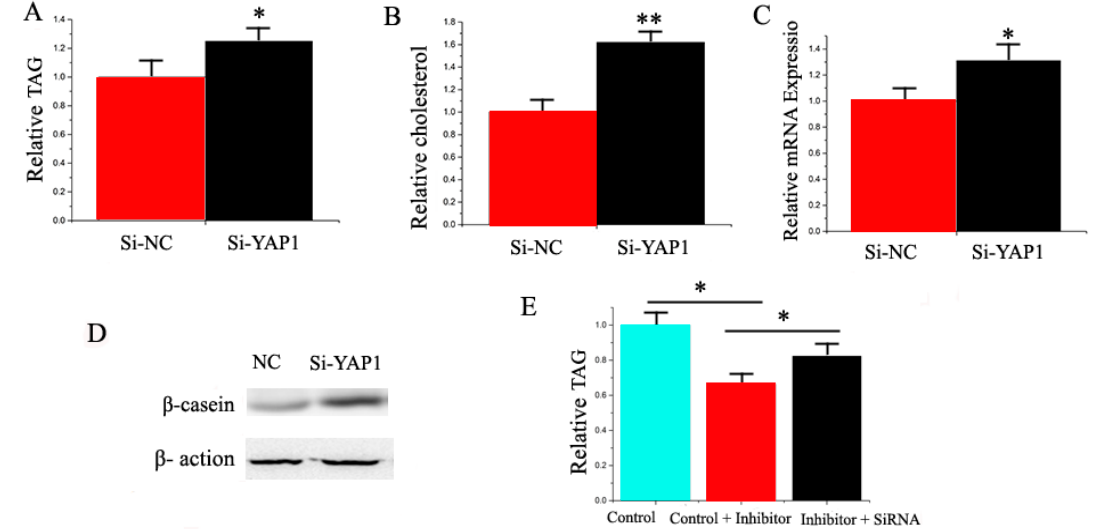
Figure 9. ( A ) Triglyceride levels in transfected cells were compared with that of control ( n = 6). Red bars represent the negative control; black bars represent miR-15a mimic or inhibitor; ( B ) Cholesterol levels in transfected cells were compared with that of the control ( n = 6). Red bars represent the negative control; black bars represent siRNA- YAP1 ; ( C ) The expression of β -casein was quantified by RT-qPCR ( n = 6); ( D ) The effect of si-NC (60 nM) or siRNA- YAP1 (60 nM) on β -casein protein expression was evaluated by Western blot in GMEC; ( E ) Triglyceride levels in cells transfected with control inhibitor (50 nM) + control siRNA (50 nM), inhibitor 15a (50 nM) + Control siRNA (50 nM), and inhibitor 15a (50 nM) + siRNA- YAP1 (50 nM). All experiments were duplicated and repeated three times. Values are presented as means ± standard errors, * p < 0.05; ** p < 0.01.